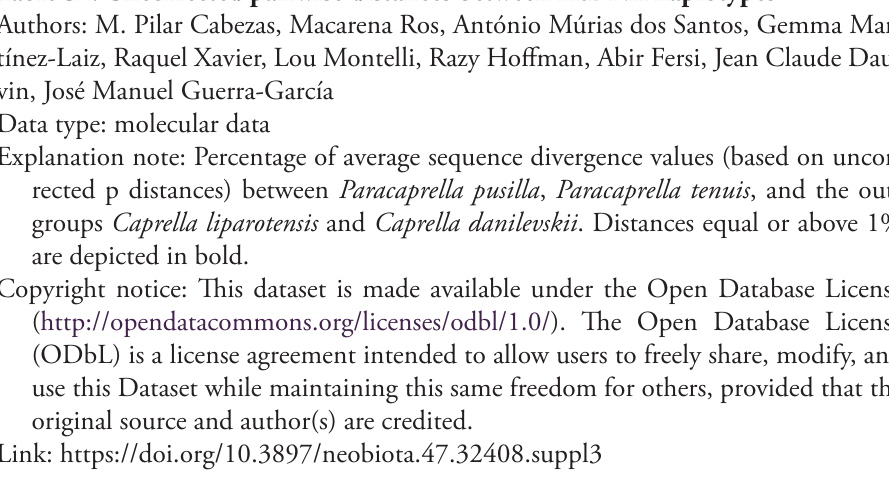
Table S2. Uncorrected pairwise distances between mtDNA haplotypes